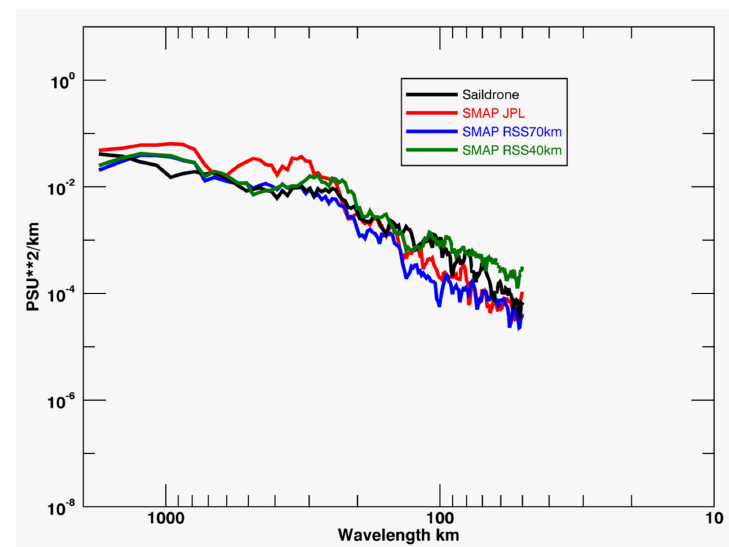
Figure 5. Wavenumber spectra for SMAP products and Saildrone.